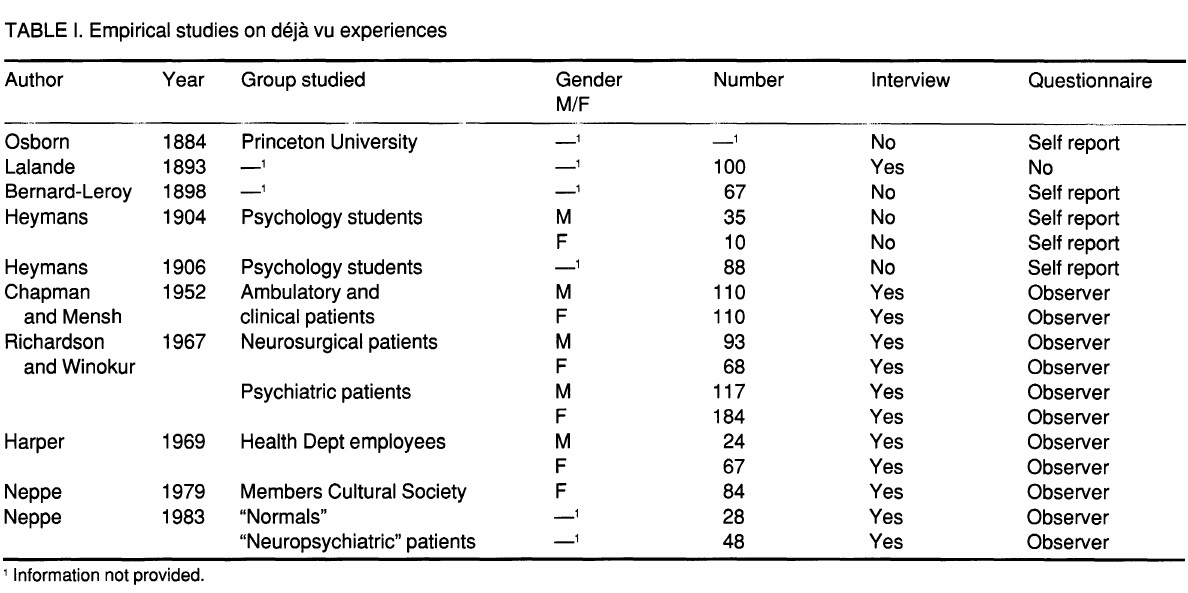
TABLE I. Empirical studies on deja vu